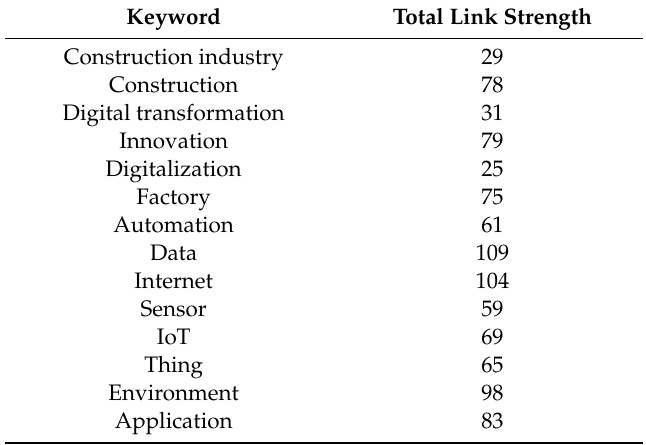
Table 8. Total link strength of keyword Industry 4.0 with its linked keywords in Scopus.